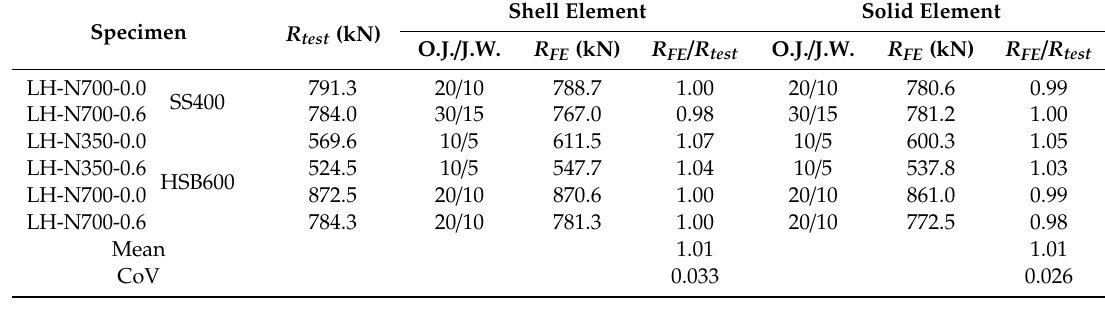
Table 5. Comparison of joint strength. CoV—coe ffi cient of variation.